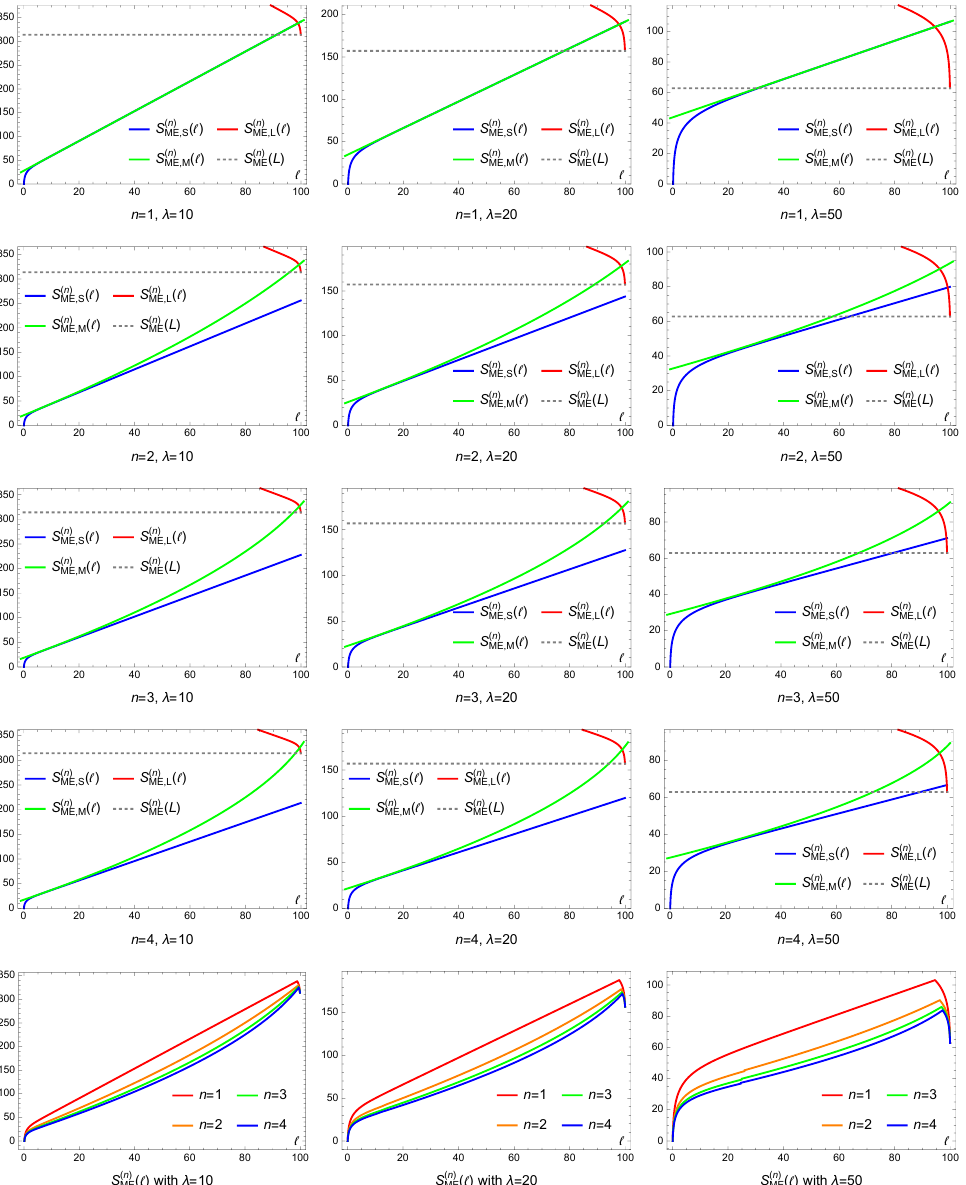
Figure 2 . In the (cid:12)rst four rows, we plot the R(cid:19)enyi entropy of short interval (3.1), medium inter- val (3.6), long interval (3.2) for microcanonical ensemble state in the thermodynamic limit, and we also plot the R(cid:19)enyi entropy of the total system (3.3). In the last row, we plot the piecewise